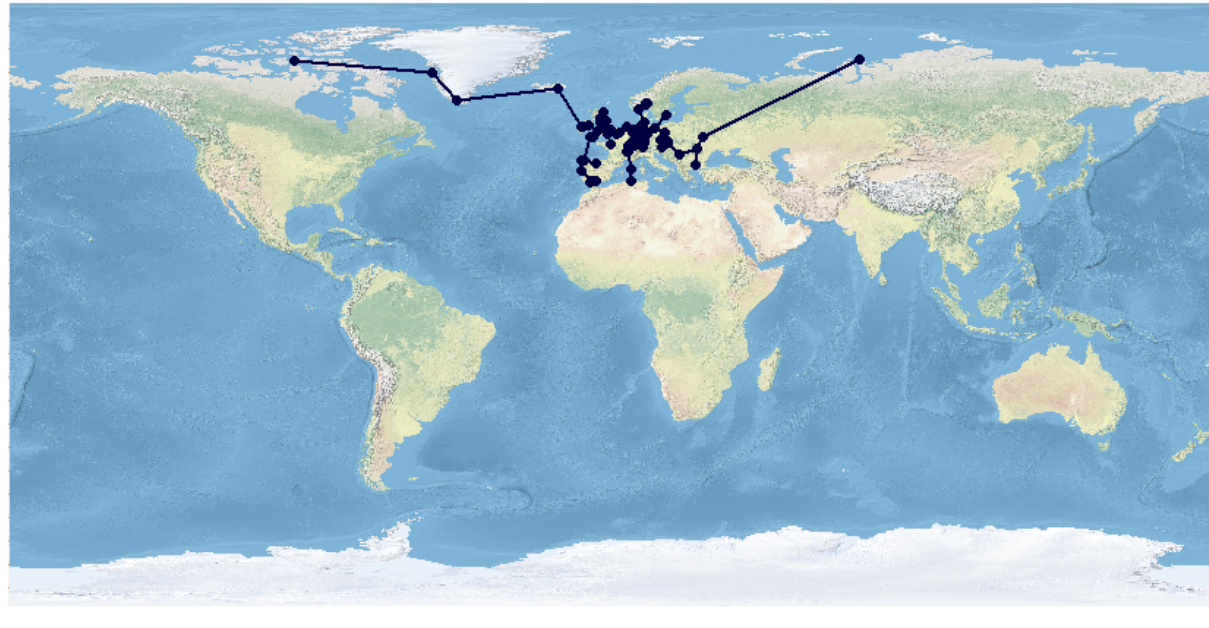
Figure 3. Individual track of Diaptomus castor